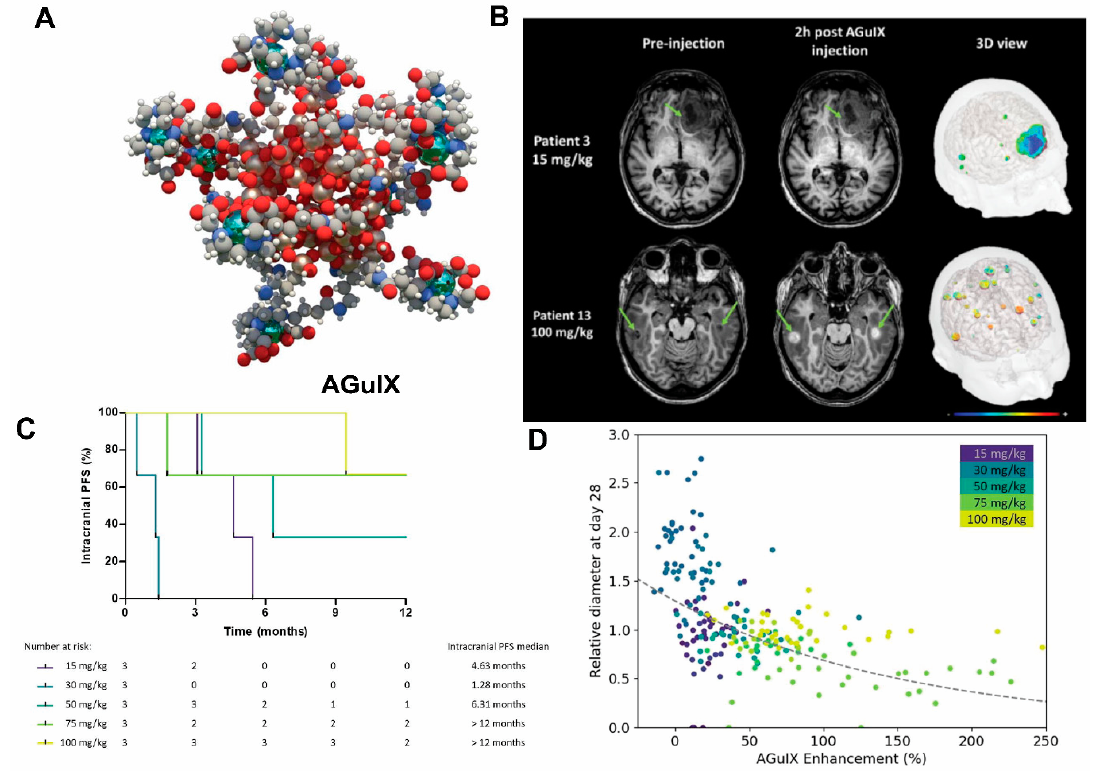
Figure 3. AGuIX as radiosynthesizer and MRI contrast-enhancing NPs in the phase I clinical trial (NANO-RAD trial). ( A ) Schematic representation of AGuIX. Gadolinium ions are chelated by 1,4,7,10-tetraazacyclododecane-1,4,7,10-tetraacetic acid derivatives. Polysiloxane core (Si, metallic grey; O, red; H, white; C, grey; N, blue) is surrounded by covalently grafted chelates of gadolinium (Gd, metallic green). ( B ) AGuIX contrast-enhanced MRI at 2 h in brain metastases of 2 patients with lung cancer following intravenous AGuIX administration at 15 and 100 mg/kg, respectively. T1-weighted MRI images were obtained without injection of contrast agent before and at 2 h after a single AGuIX intravenous administration at the indicated concentration. Green arrows are pointing highlighted metastases. The 3-D vizualization of entire brain with specific contrast enhancement into metastases was obtained from T1-weighted MRI mapping. ( C ) Intracranial progression-free survival (PFS) of multiple patients with brain metastases treated with a combination of whole-brain radiotherapy (WBRT) and different dose levels of intravenous AGuIX. The color of survival curves corresponds to different AGuIX doses. ( D ) Correlation between change in size of brain metastases and AGuIX signal variation. Correlation of measured metastasis sizes for patients with brain metastases and treated with whole brain radiotherapy and different AGuIX doses. Points colored according to patient number and administrated dose with darker colors corresponding to lower AGuIX doses. Metastasis diameter at 28 days normalized to diameter at Day 0 (V28/V0) as a function of AGuIX enhancement (points) compared with predicted trend (dashed line), showing good agreement and dependence of metastasis evolution on AGuIX uptake. AGuIX, Activation and Guidance of Irradiation by X-Ray. Figures were adapted based on Refs. [111,113] with permissions.